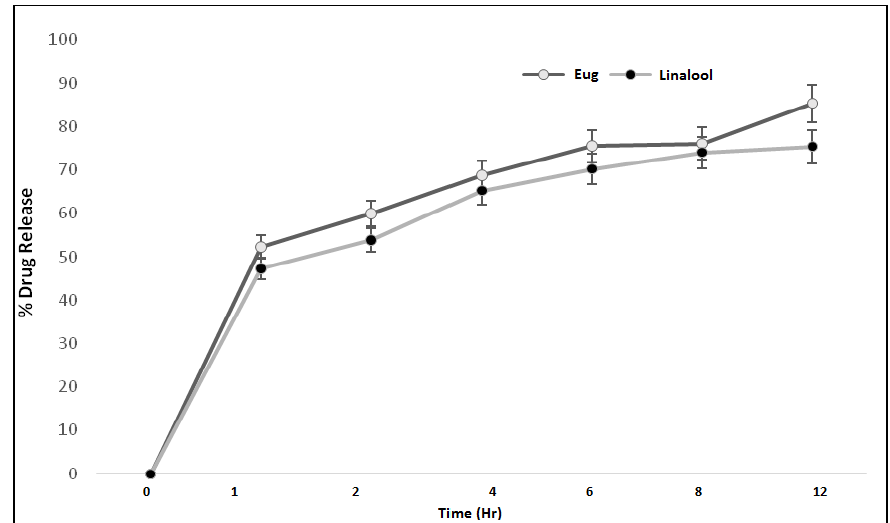
Figure 5. Percent drug release of eugenol and linalool from ELE2 at different time intervals.